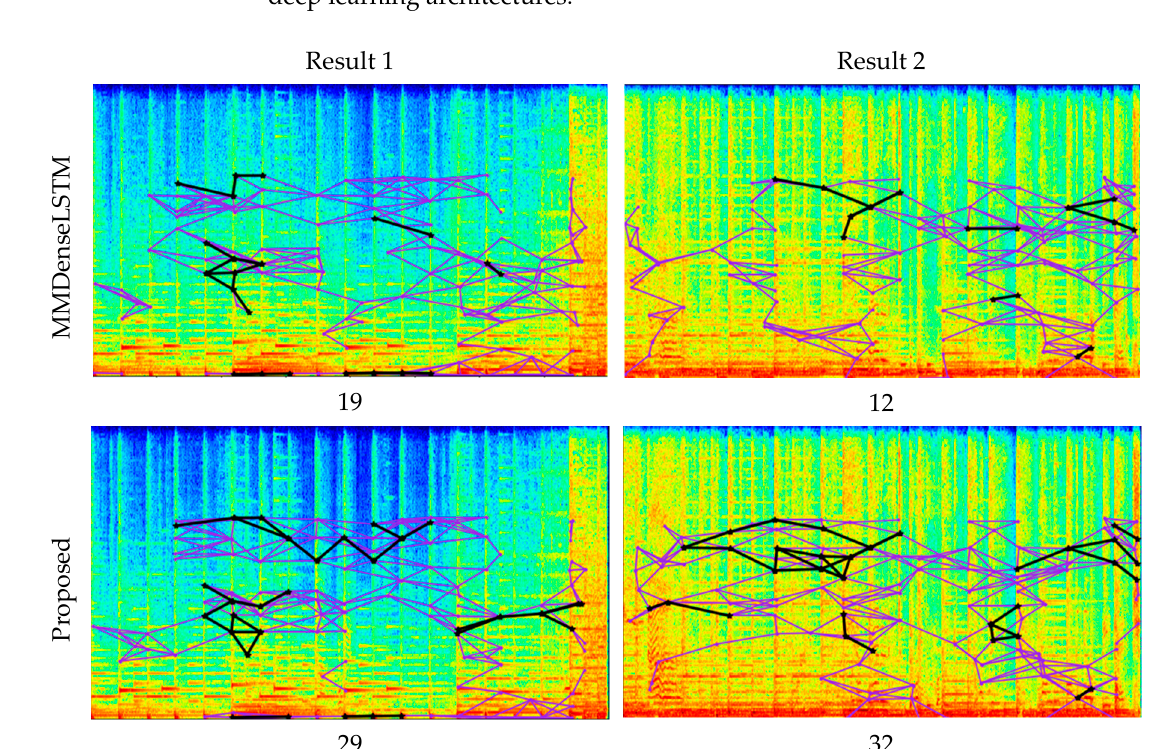
Figure 8. Fingerprint plots at spectrogram. The horizontal axis is time and the vertical axis is frequency. The violet line